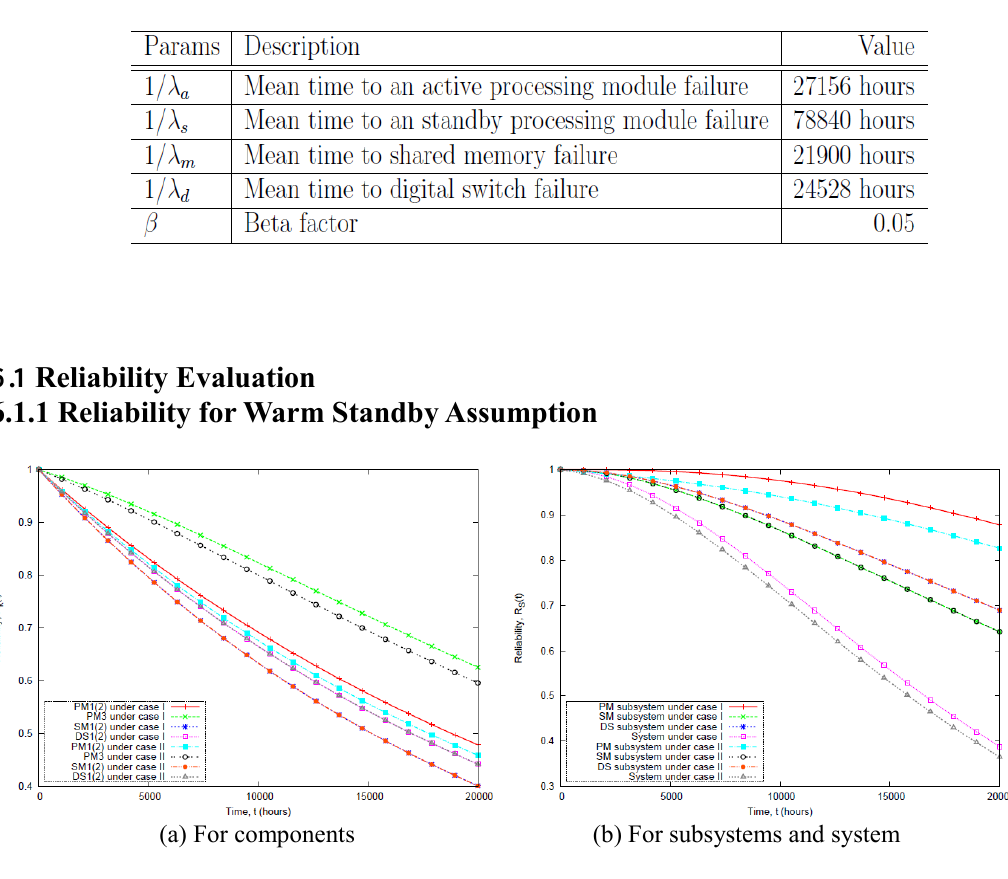
Fig. 7. Reliabilities of all components, subsystems, and system with warm standby as a function of time under two